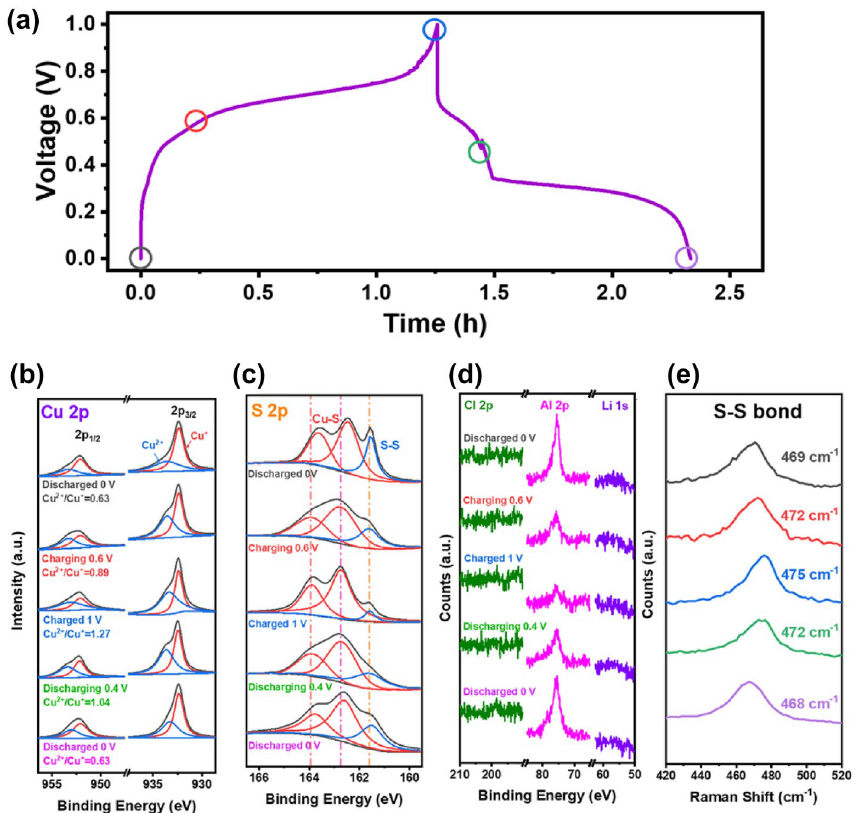
Figure 5. Ex-situ XPS and Raman of CuS under different charge/discharge states: ( a ) GCD profile, ( b , c , d ) ex-situ XPS spectra and ( e ) ex-situ Raman